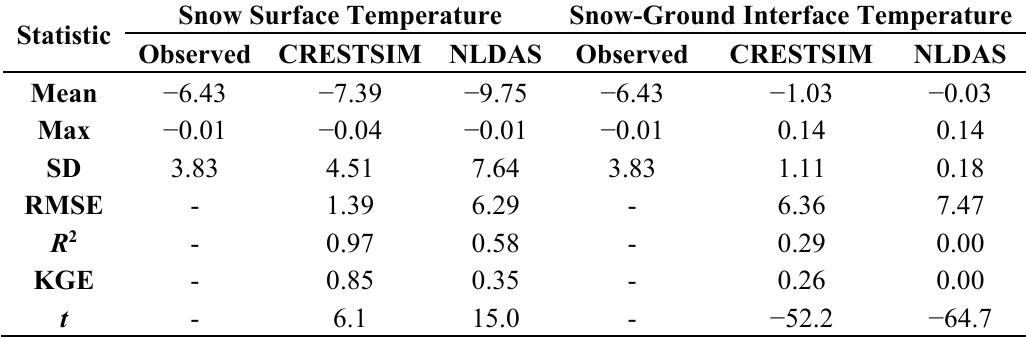
Figure 12. Time series for temperature (°C) in the surface ( upper ) and snow-ground interface ( lower ) snowpack boundaries. Legend: NLDAS meteorological data simulation (NLDAS), CREST-SAFE meteorological data simulation (CRESTSIM), and manual CREST-SAFE observations (Observed). Validation period: Winter 2011–2012. The number of observations was 975 for top and 2030 for bottom. Table 5. Statistics for surface and snow-ground interface snowpack temperatures (°C). Validation period: Winter 2011–2012. Row definitions are same as in Table 3. The number of observations was 2030 and 975